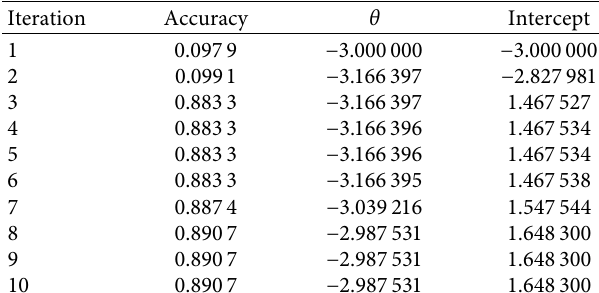
Figure 3: Accuracy of forecasts during iterations. Table 2: Summary of the